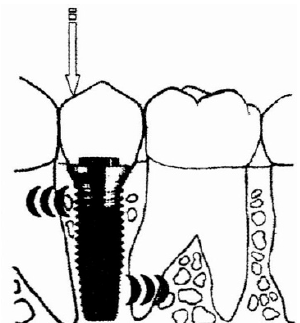
Figure 2. Peri-implant tissue force dissipation. Arrow shows the occlusal load, and the dissipation of these forces to the bone has been marked.